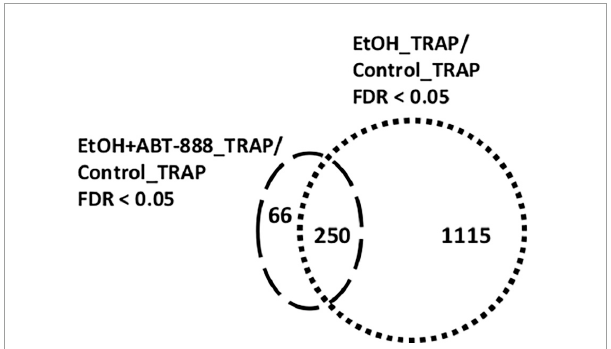
FIGURE4 Venn diagram illustrating the differentially expressed transcripts identified in the different datasets. In RE (TRAP-seq) samples, administration of EtOH caused the differential distribution of 1,365 ribosomal transcripts ( Table 1 ; B1) (EtOH_TRAP vs Control_TRAP; FDR < 0.05) represented by the “dotted” circle. Co-administering the PARP inhibitor ABT-888 (EtOH + ABT-888) resulted in 316 transcripts differentially altered compared to control (EtOH + ABT-888_TRAP vs Control_TRAP; FDR < 0.05; Table 1 -B2) represented by the “dashed” circle. Out of these 316 transcripts, 66 were uniquely altered by EtOH + ABT-888, but not EtOH, whereas 250 transcripts were altered by both EtOH and EtOH + ABT-888. This yielded 1,115 transcripts (1365-250) that were altered exclusively by EtOH and no longer by ABT-888 (or “reversed by ABT-888”) compared to Control.